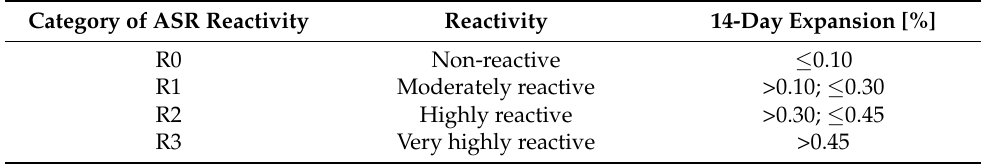
Table 1. Category of ASR reactivity according to PB/1/18 [10]. Category of ASR